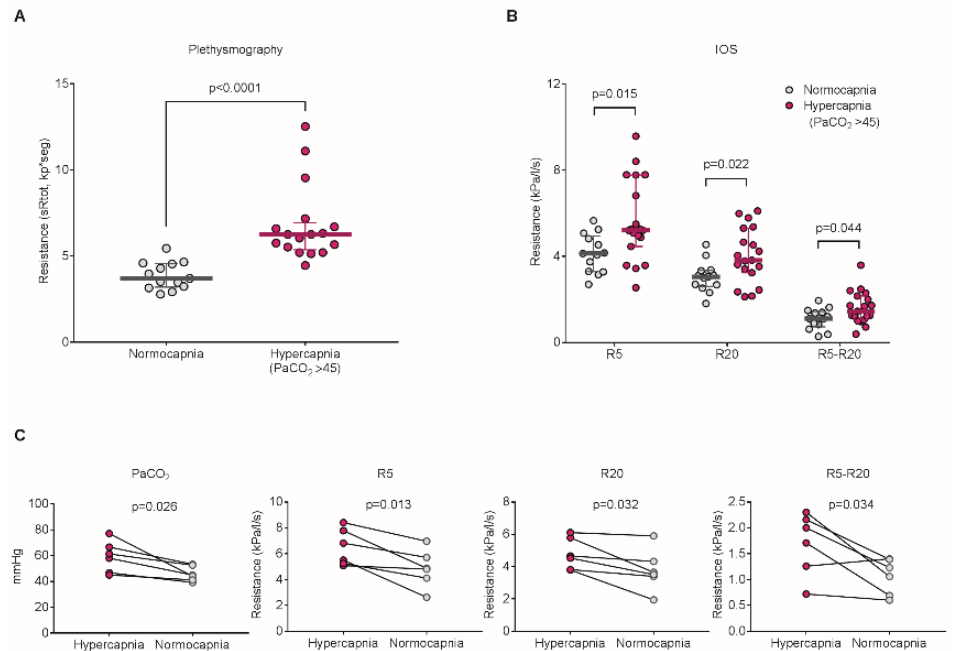
Figure 1. Hypercapnia increases airway and respiratory resistance in patients with chronic obstructive pulmonary disease (COPD). ( A ) Comparison of airway resistance (sR tot ) measured by plethysmographic assessment between normocapnic and hypercapnic patients. ( B ) Comparison of respiratory resistance measured by impulse oscillometry (IOS) between normocapnic and hypercapnic patients. Values of R5, R20, and R5-R20 indicate total, proximal, and peripheral respiratory resistance, respectively. ( C ) Changes of respiratory resistance in hypercapnic patients. Reproduced from [26]. Copyright © 2018 American Association for the Advancement of Science.